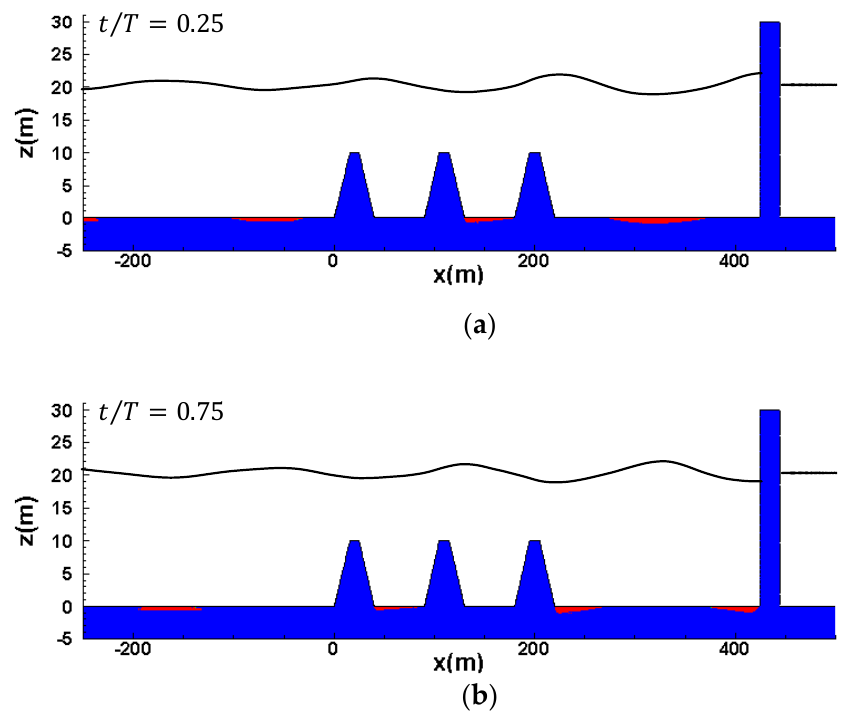
Figure 24. Distribution of the wave − induced liquefaction zone around the breakwaters with a period of kd = 0.6 under Mode 2 (at S / L = 1.0). ( a ) t / T = 0.25; ( b ) t / T = 0.75 .